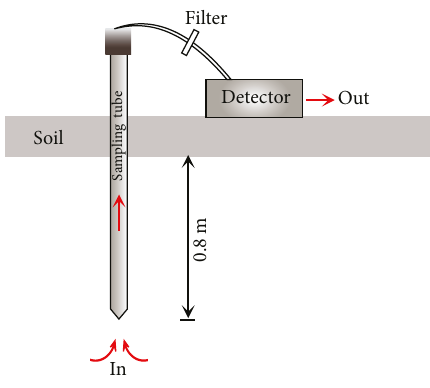
Figure 2: Sketches of the methods used for soil gas measurement at the mobile measurement